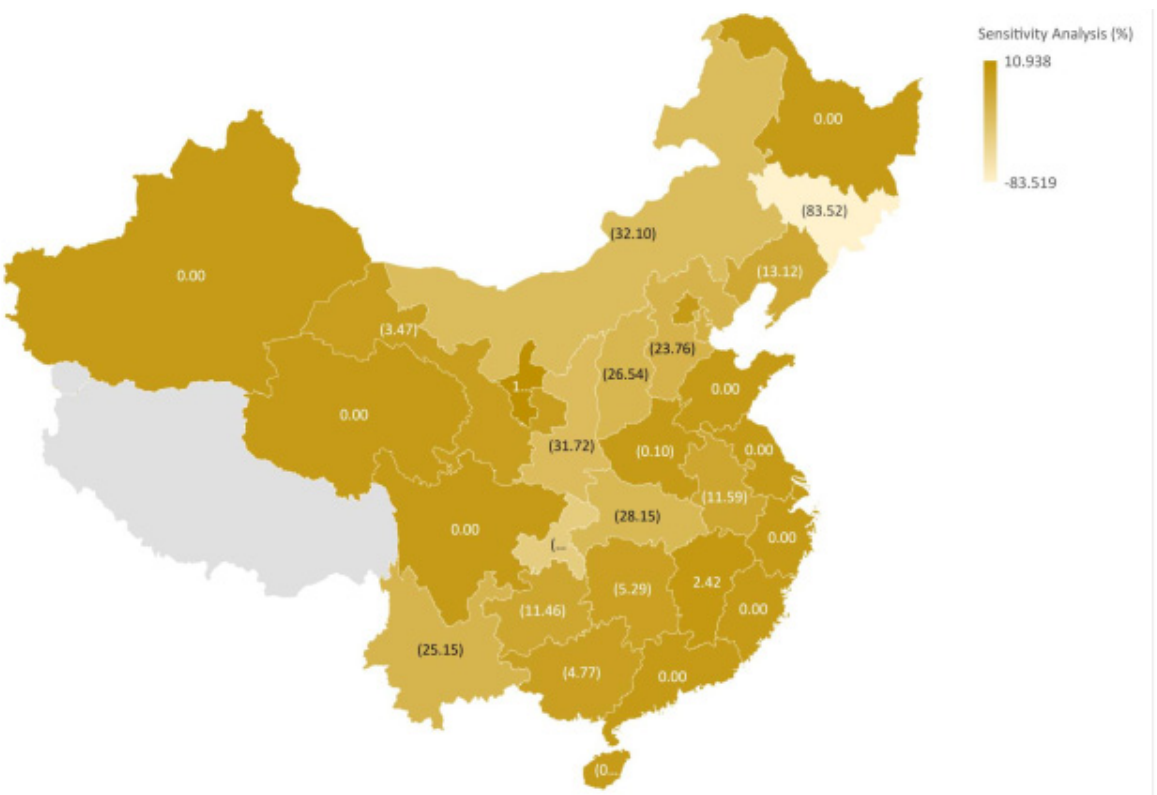
Figure 6. Sensitivity scenarios for water use e ffi ciency.